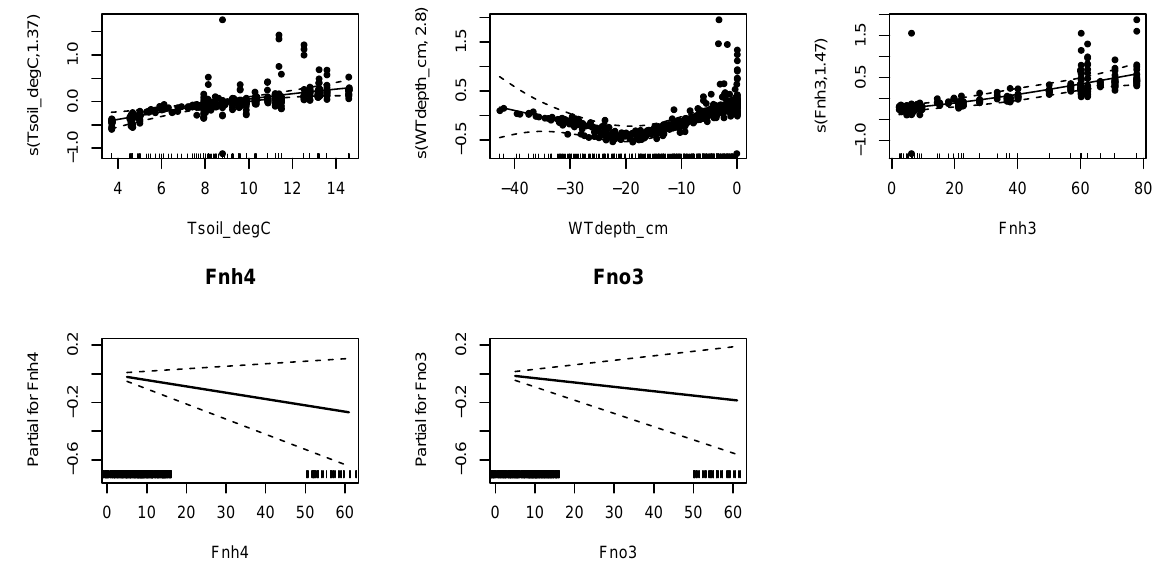
Figure 4. Fitted response of N 2 O flux to soil temperature, water table height, and deposition of NH 3 , NH + general additive mixed model. Partial residuals are shown for the smooth terms, which are the residuals that would be obtained by dropping the term concerned from the model, while leaving all other estimates fixed. NH + lines show 2 standard errors above and below the fitted estimate.